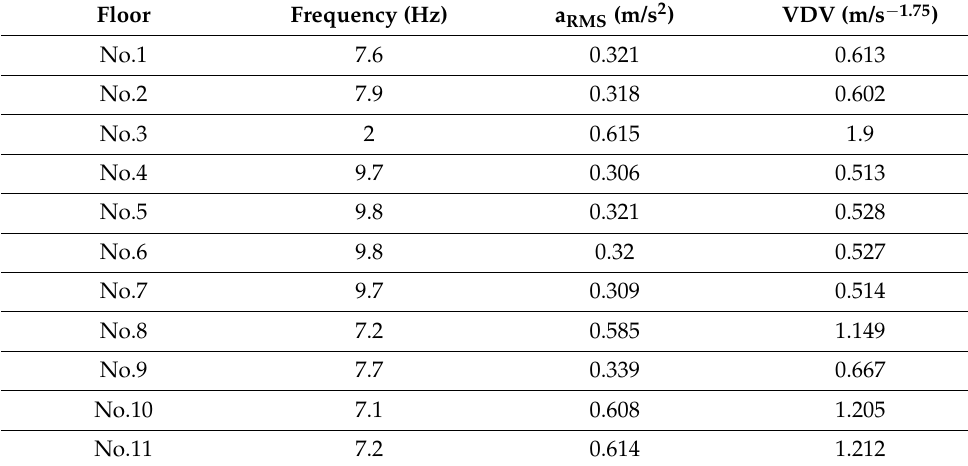
Table 8. Floor responses in terms of frequency, RMS acceleration and VDV due to running as described in Huang et al. [44].